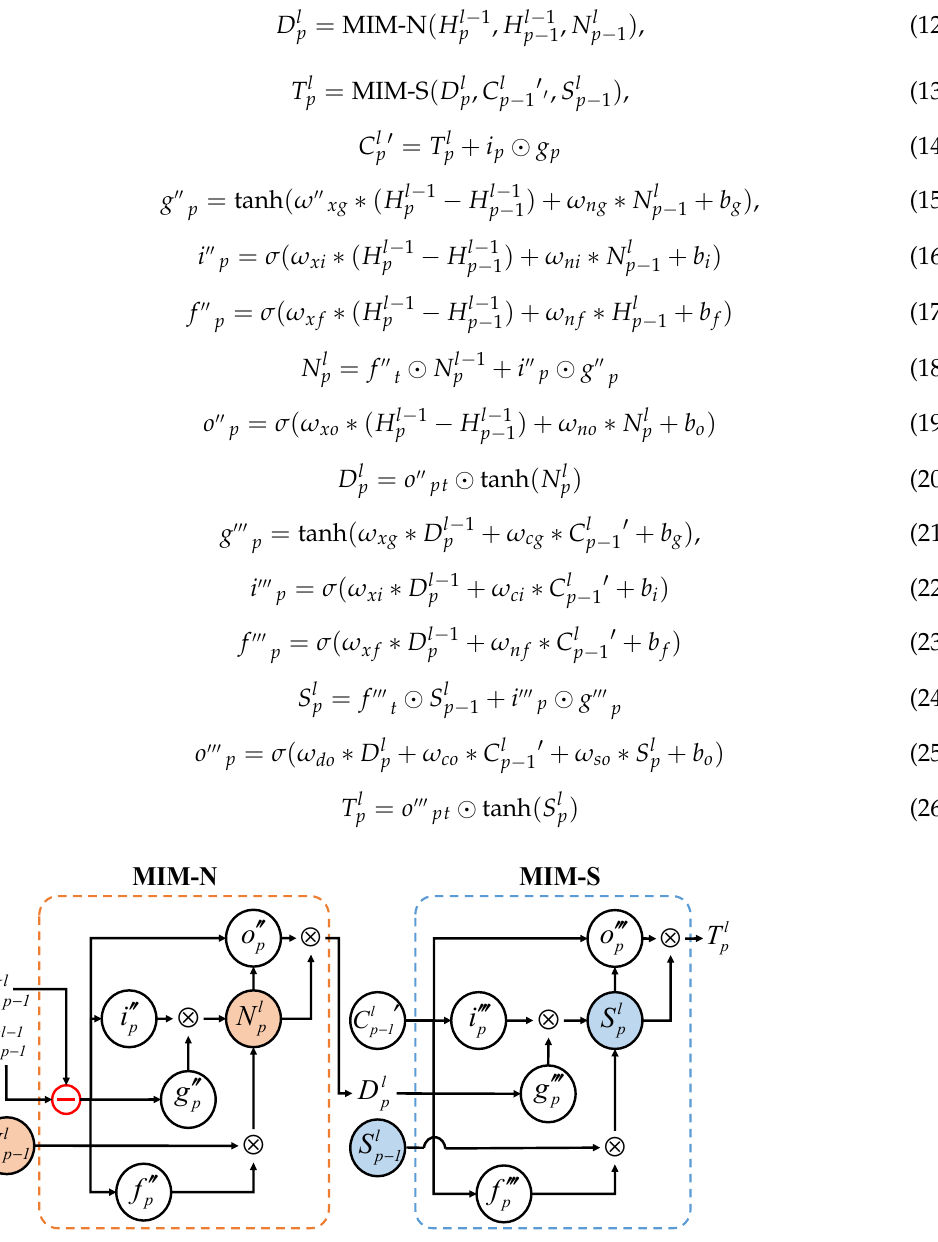
(cid:48) , the spatiotemporal memory M l − 1 C l , and the hidden state H l were also used as the p p − 1 p − 1 input of MIM. The non-stationary model (MIM-N) generated the differential features D l to p capture the non-stationary variations of the temporal differencing, as shown in Figure 4. (cid:48) were taken as The output D l of the MIM-N model and the outer temporal memory C l p p − 1 inputs of the stationary model (MIM-S) to capture the approximately stationary variations in spatiotemporal sequences, as shown in Figure 4.